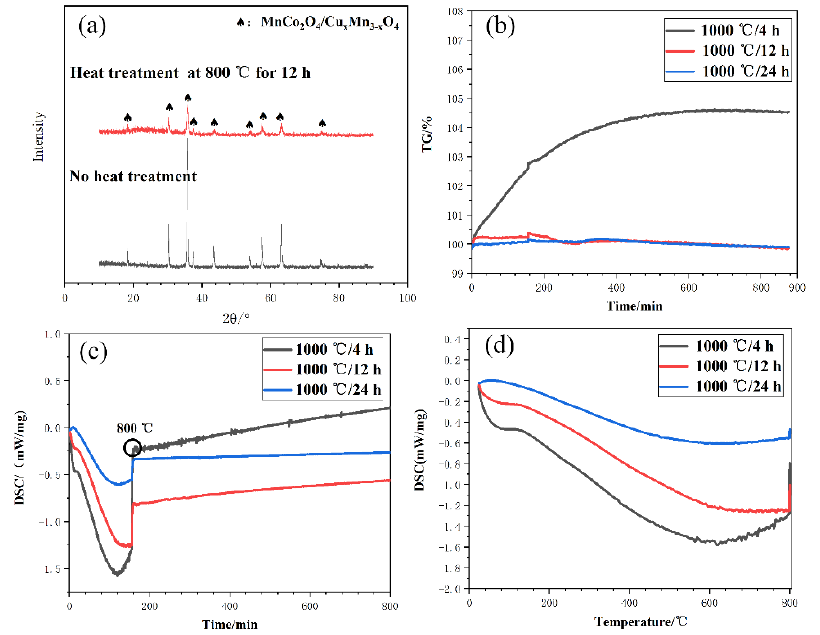
Figure 8. ( a ) XRD patterns before and after heating at 800 °C of powder sintered at 1000 °C for 12 h; ( b , c ) TG-DSC curves of powders sintered at 1000 ◦ C for 4 h, 12 h, and 24 h; ( d ) DSC curves during ( b , c ) TG ‐ DSC curves of powders sintered at 1000 °C for 4 h, 12 h, and 24 h; ( d ) DSC curves during the heating the heating process.